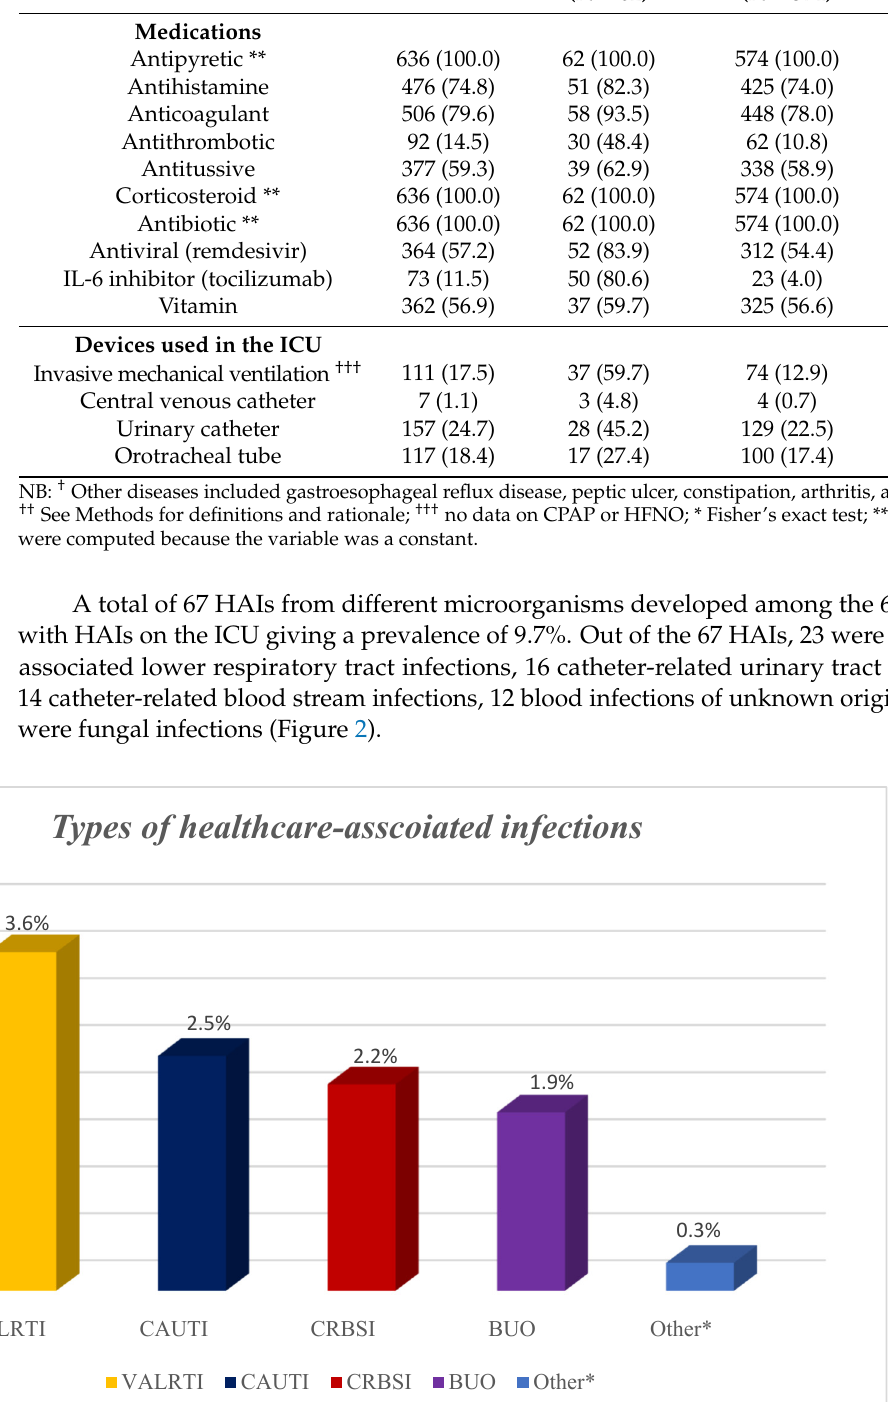
Figure 3. Details of microorganisms responsible for healthcare-associated infections. Note: The numbers refer to the number of patients with these isolates along with the percentages ( n = 67).